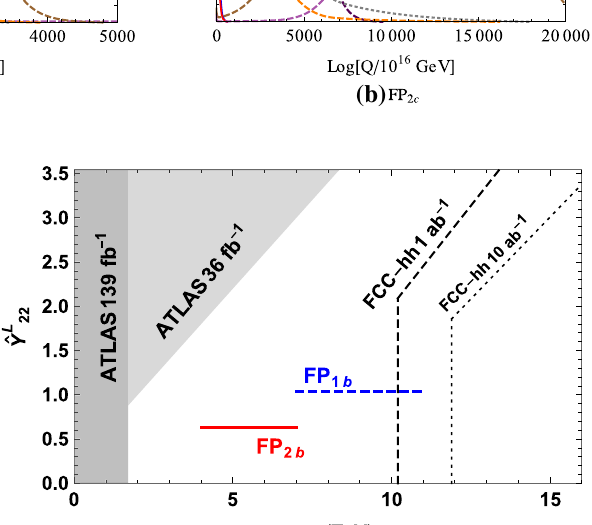
→ μ + μ − ) = ( 6 . 84 ± 0 . 11 ) × 10 − 9 [105], BR ( K 0 L